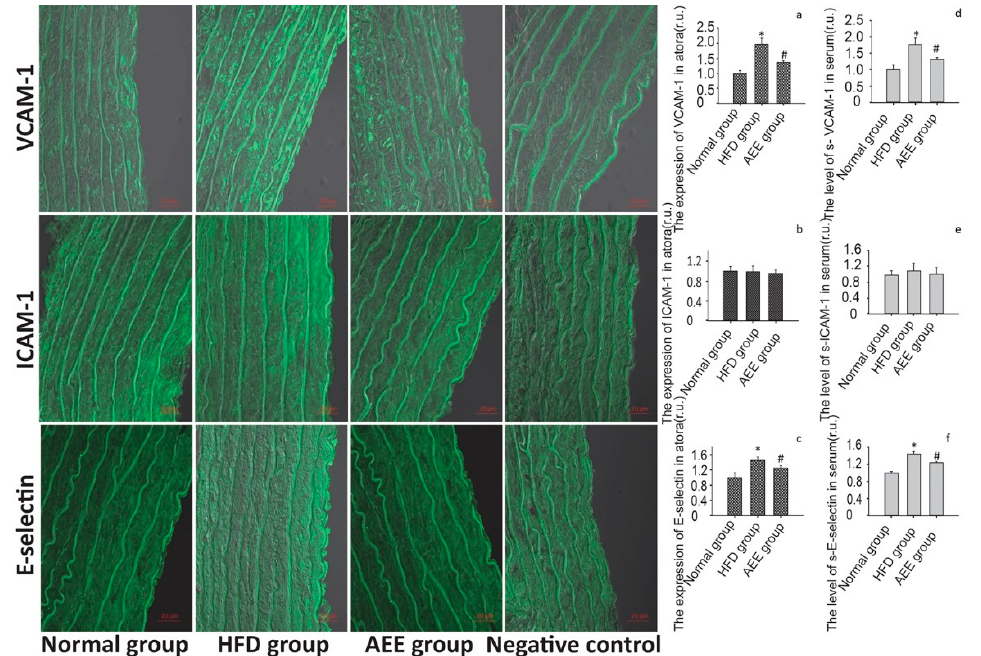
Figure 3. AEE reduced the expression of adhesion molecules in rats fed the HFD. ( a – c ): AEE reduced VCAM-1 and E-selectin expression in the aorta. Values are presented as the means ± SD where applicable ( n = 8). * p < 0.05 compared with the normal group; # p < 0.05 compared with the HFD group. All data were normalized to the corresponding control and reported in relative units (r.u.). ( d – f ): AEE decreased the serum sVCAM-1 and sE-selectin levels. Values are presented as the means ± SD where applicable ( n = 8). * p < 0.05 compared with the normal group; # p < 0.05 compared with the HFD group. All data were normalized to the corresponding control and reported in relative units (r.u.).